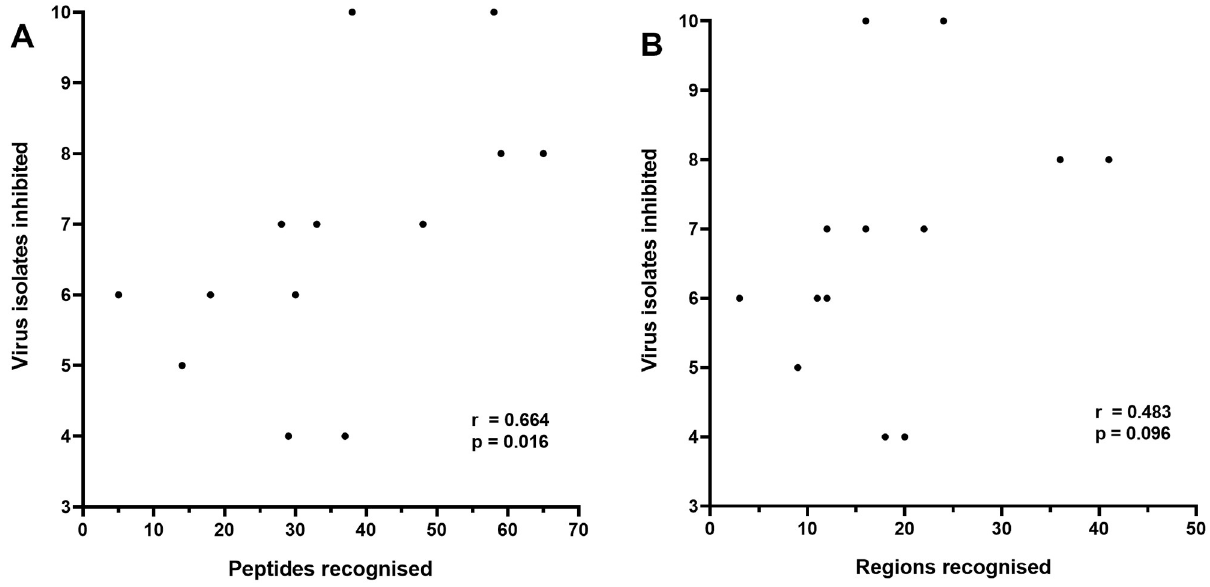
Fig 5. Correlations between the number of HIV-1 isolates inhibited and A) the total number of PTE peptides recognised and B) the total number of PTE epitope regions recognised. A non-parametric Spearman test was used to compute the correlation coefficients (r) between the datasets.